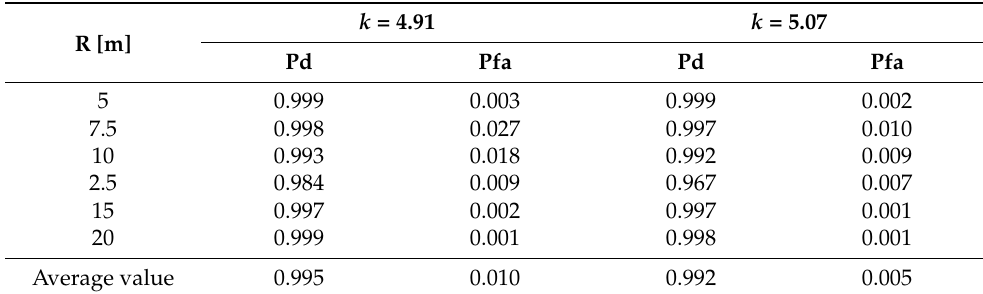
Table 3. Detection Probability and False Alarm Probability for the test scenarios, for k = 4.91 and k =